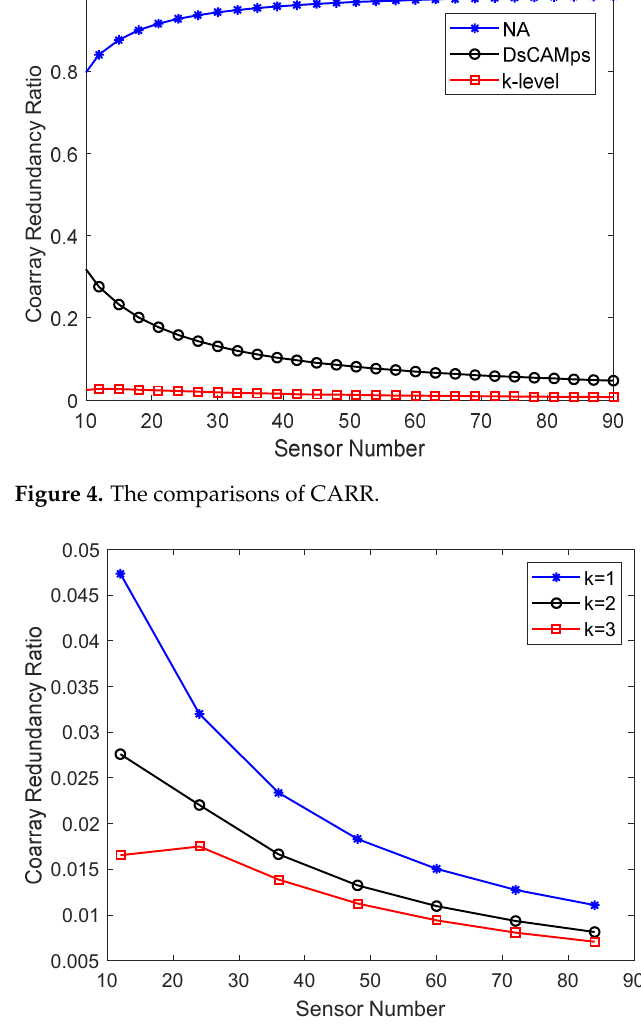
Figure 5. The CARR versus k .